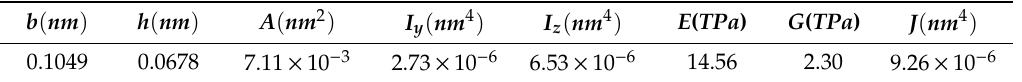
Table 1. The parameters of the rectangular beam element